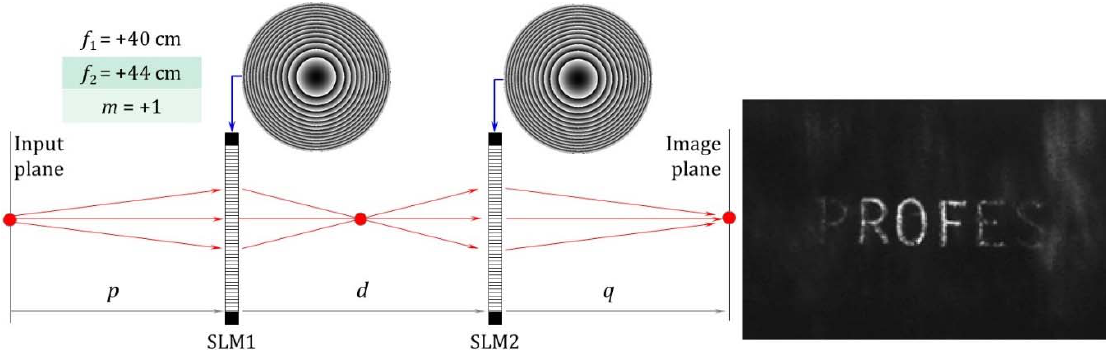
Figure 8. Zoom system configuration with f 1 = +31.8 cm and f 2 = +50 cm and experimental image with magnification of m = +0.5.